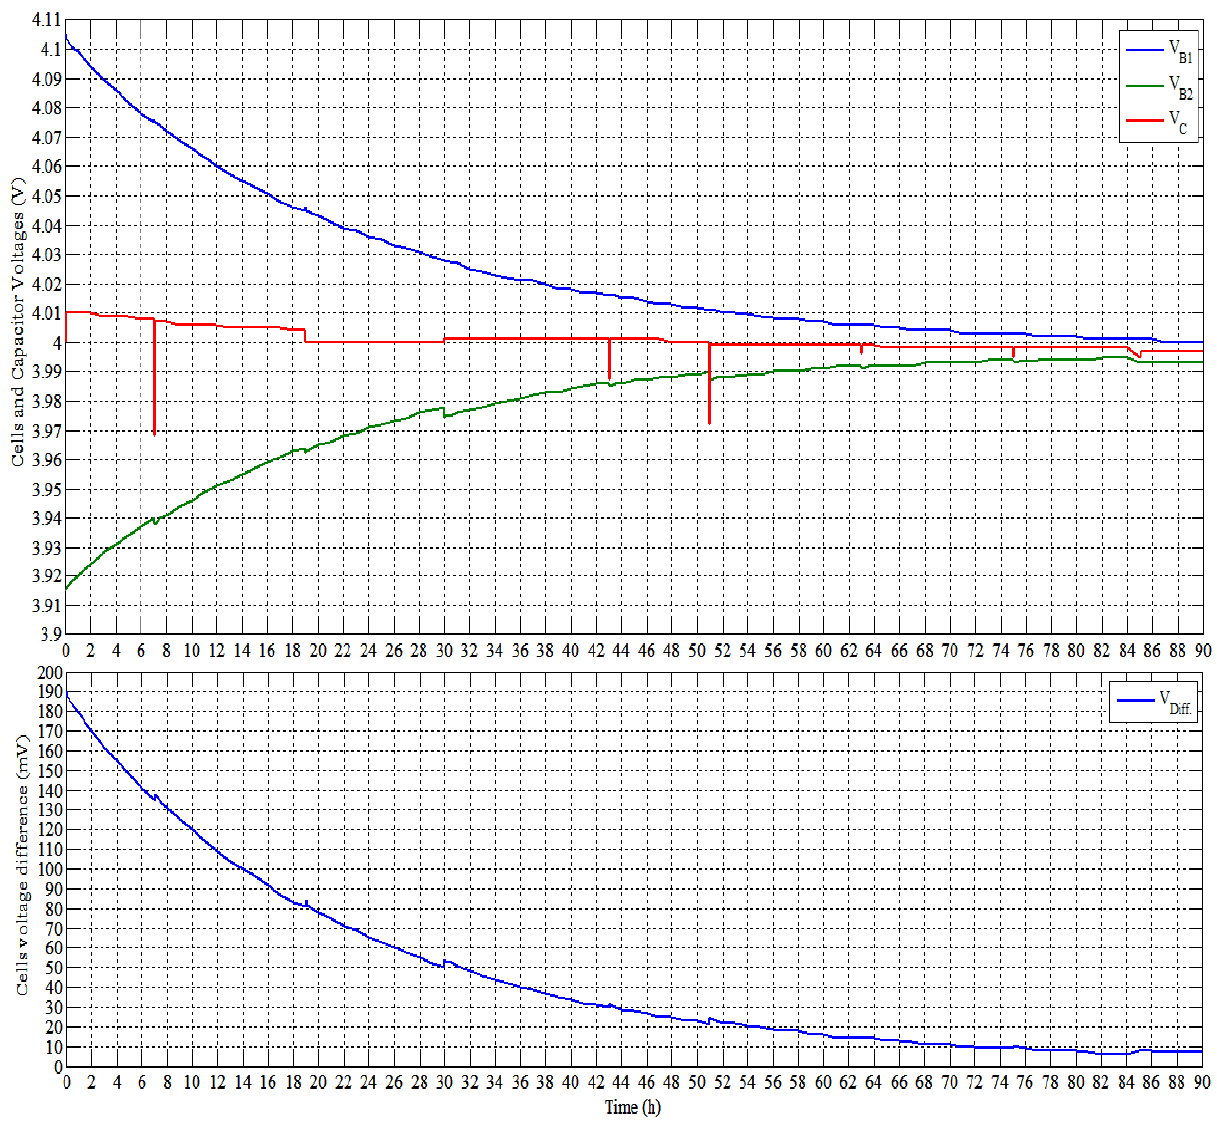
Figure 34. Experimental results of 20 A·h cells with SSC open-loop balancing (Test No.